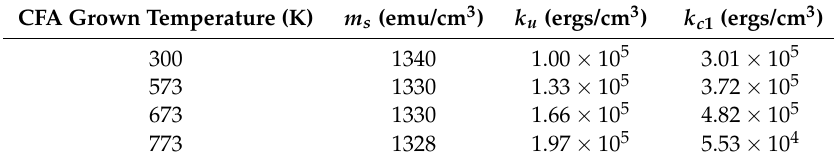
Table 1. Parameters obtained from the fits of the experimental FMR data for our set of Co 2 FeAl/W bilayers. For the fits, we assumed α ≈ 2 × 10 − 3 and γ = 2.8 MH/Oe. CFA Grown Temperature